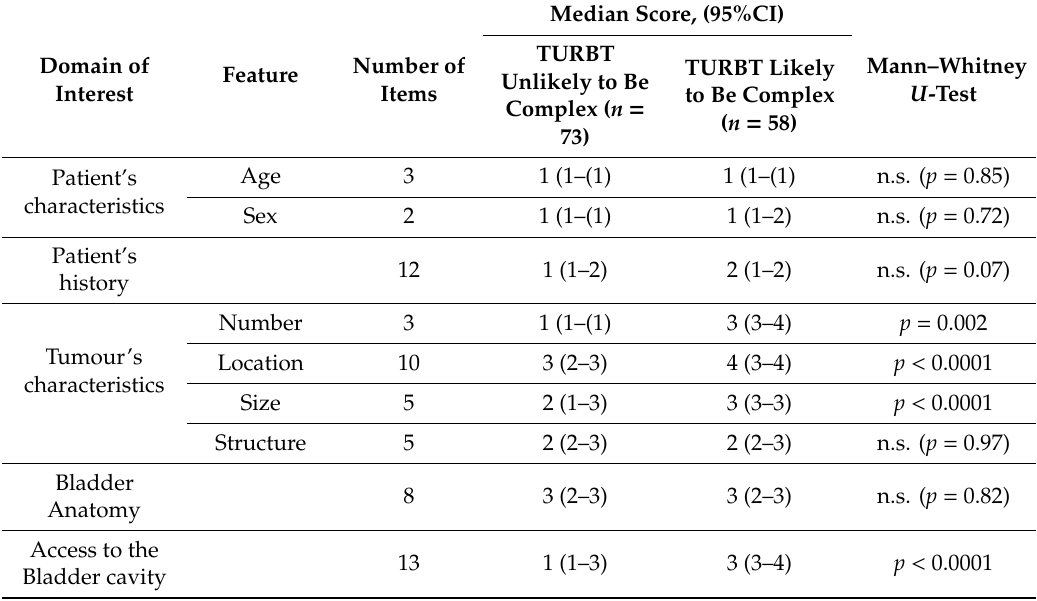
Table 1. Univariate analysis of the scores of preoperative characteristics in a cohort of 131 random scenarios for which the panel was consistent in its anticipation of complexity.